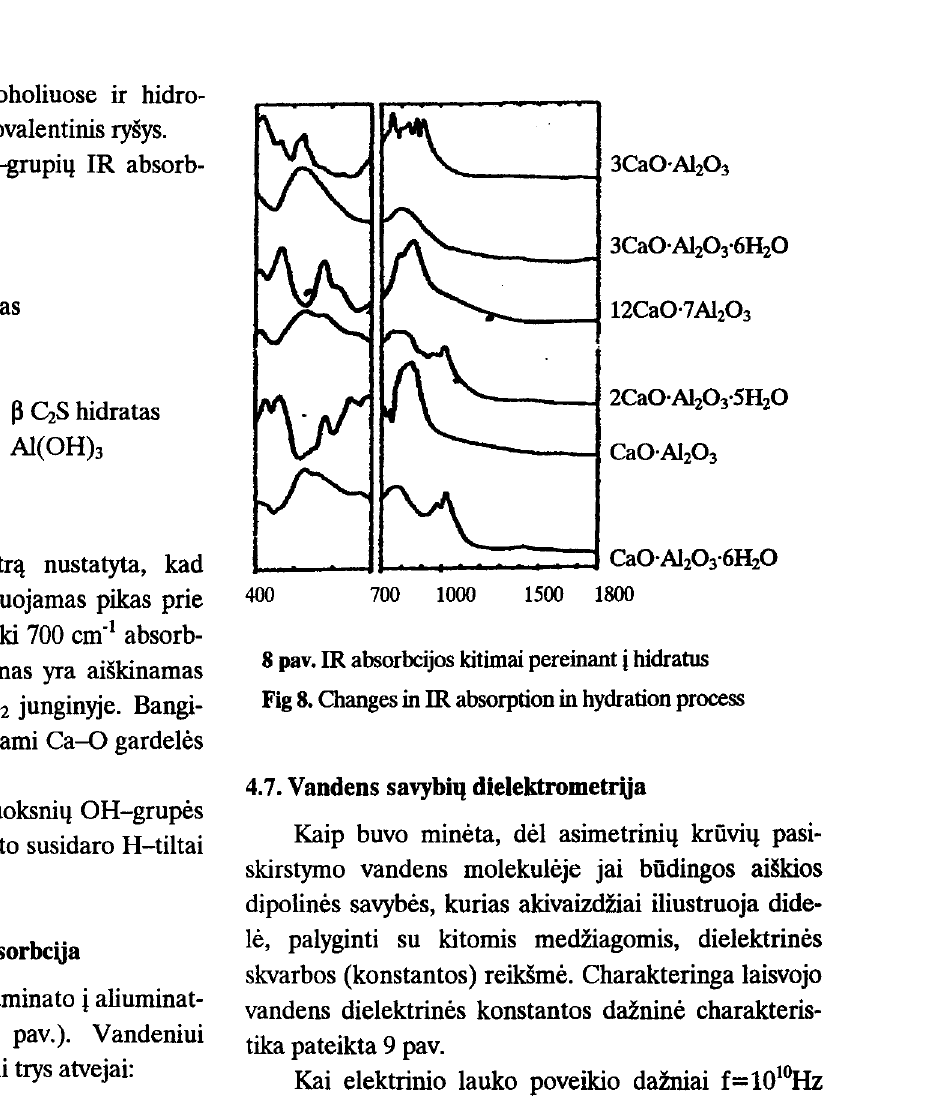
Fig 8. Changes in IR absorption in hydration process